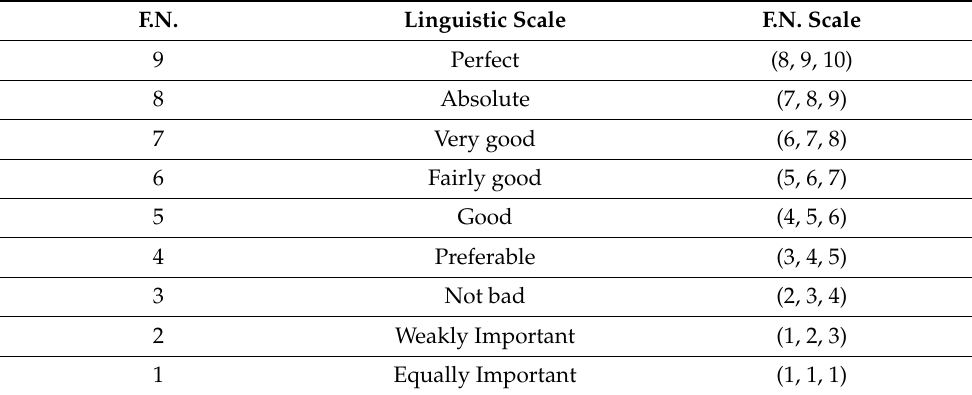
Table 1. Linguistic scale of the scale fuzzy